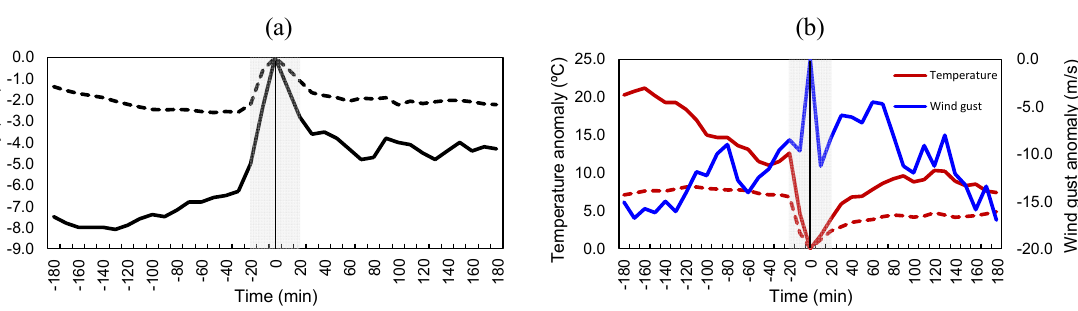
Figure 11. ( a ) Chronological profile (solid curve) of sea level pressure anomalies (w. r. t. the event instant) for the case study (17 June 2017), over a 6-hour window centered at the instant of the SLP surge, recorded at WS 570 (Castelo Branco). The event occurrence is tracked with a vertical black line. The vertical grey-shaded bar represents the ± 20-minute interval for the application of the conditions for pressure surge identification (see text for details). The corresponding mean profile taken for all pressure surges recorded at WS 570 (8 events with 10-minute precipitation ≥ 5.0 mm, 5 RegL, and 3 RemL) is also shown (dashed curve). ( b ) Profile shown as in ( a ) but with data for the 2-meter temperature and wind gust anomalies for the case study (17 June 2017). The mean 2-meter temperature anomalies for all pressure surges are also plotted (dashed curve).